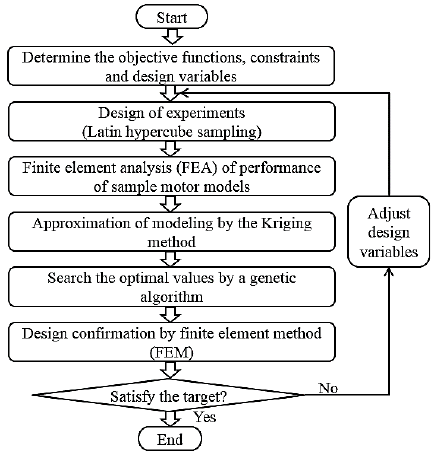
Figure 10. Optimal design process.